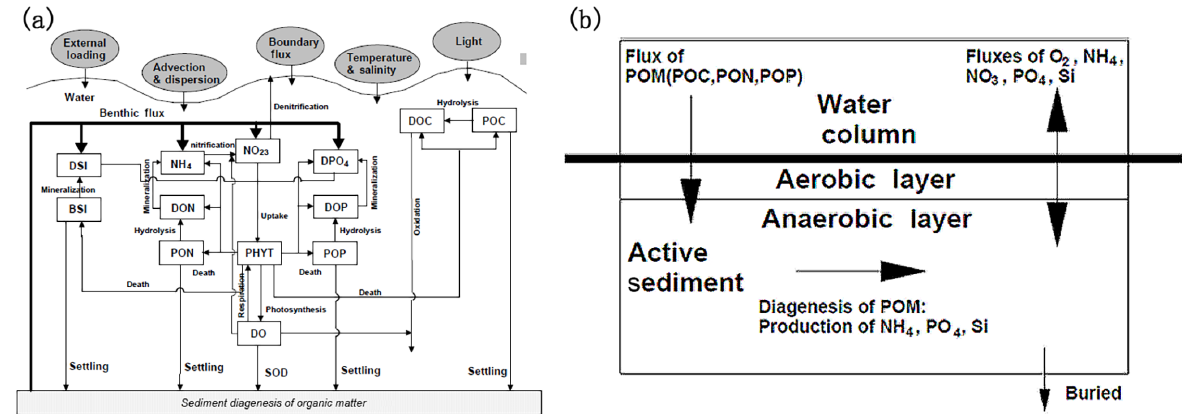
Figure 2. A conceptual framework for (a) RCA model and (b) sediment flux model (revised from Di Toro, 2001): dissolved oxygen (DO); phytoplankton (PHYT); particulate organic carbon (POC); dissolved organic carbon (DOC); ammonia nitrogen (NH 4 ) ; nitrite and nitrate nitrogen (NO 23 ) ; particulate organic nitrogen (PON); dissolved organic nitrogen (DON); dissolved inorganic phosphorus (DPO 4 ) ; particulate organic phosphorus (POP); dissolved organic phosphorus (DOP); dissolved silica (DSi); biogenic silica (BSi); sediment oxygen demand